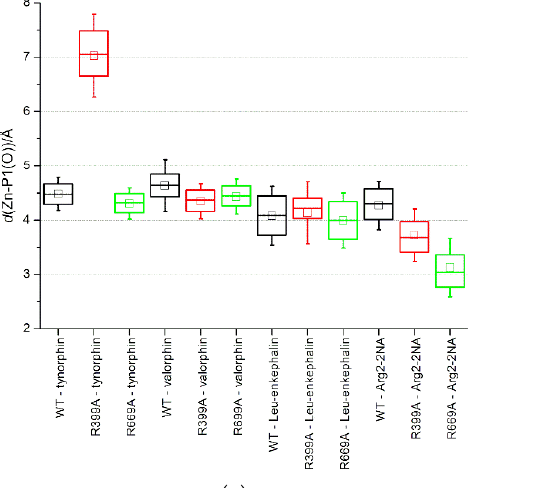
Table 3. Results of the Michaelis–Menten test for the hydrolysis of Arg 2 -2NA in the presence of DPP